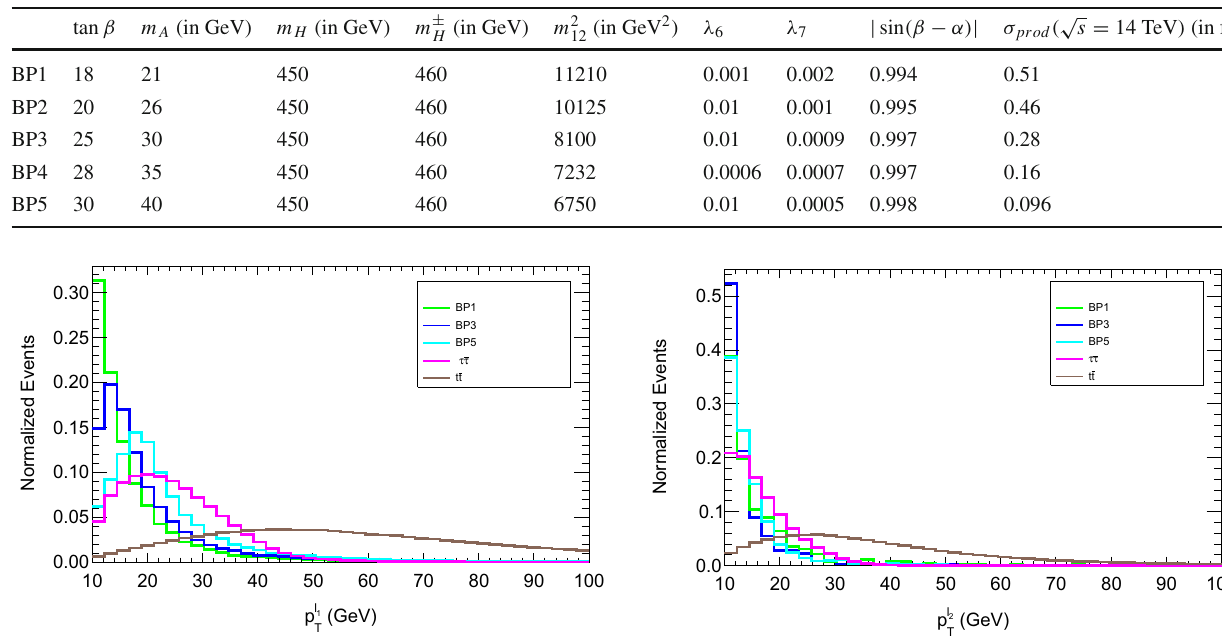
Table 1 Benchmark points allowed by all constraints and the corresponding production cross-section of our signal at LO at 14 TeV LHC